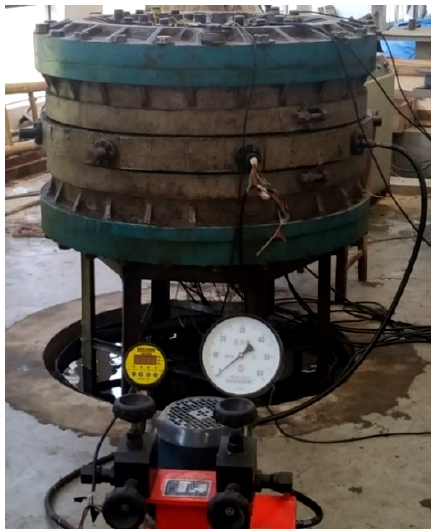
Figure 11. Shaft lining structure high-pressure loading device.